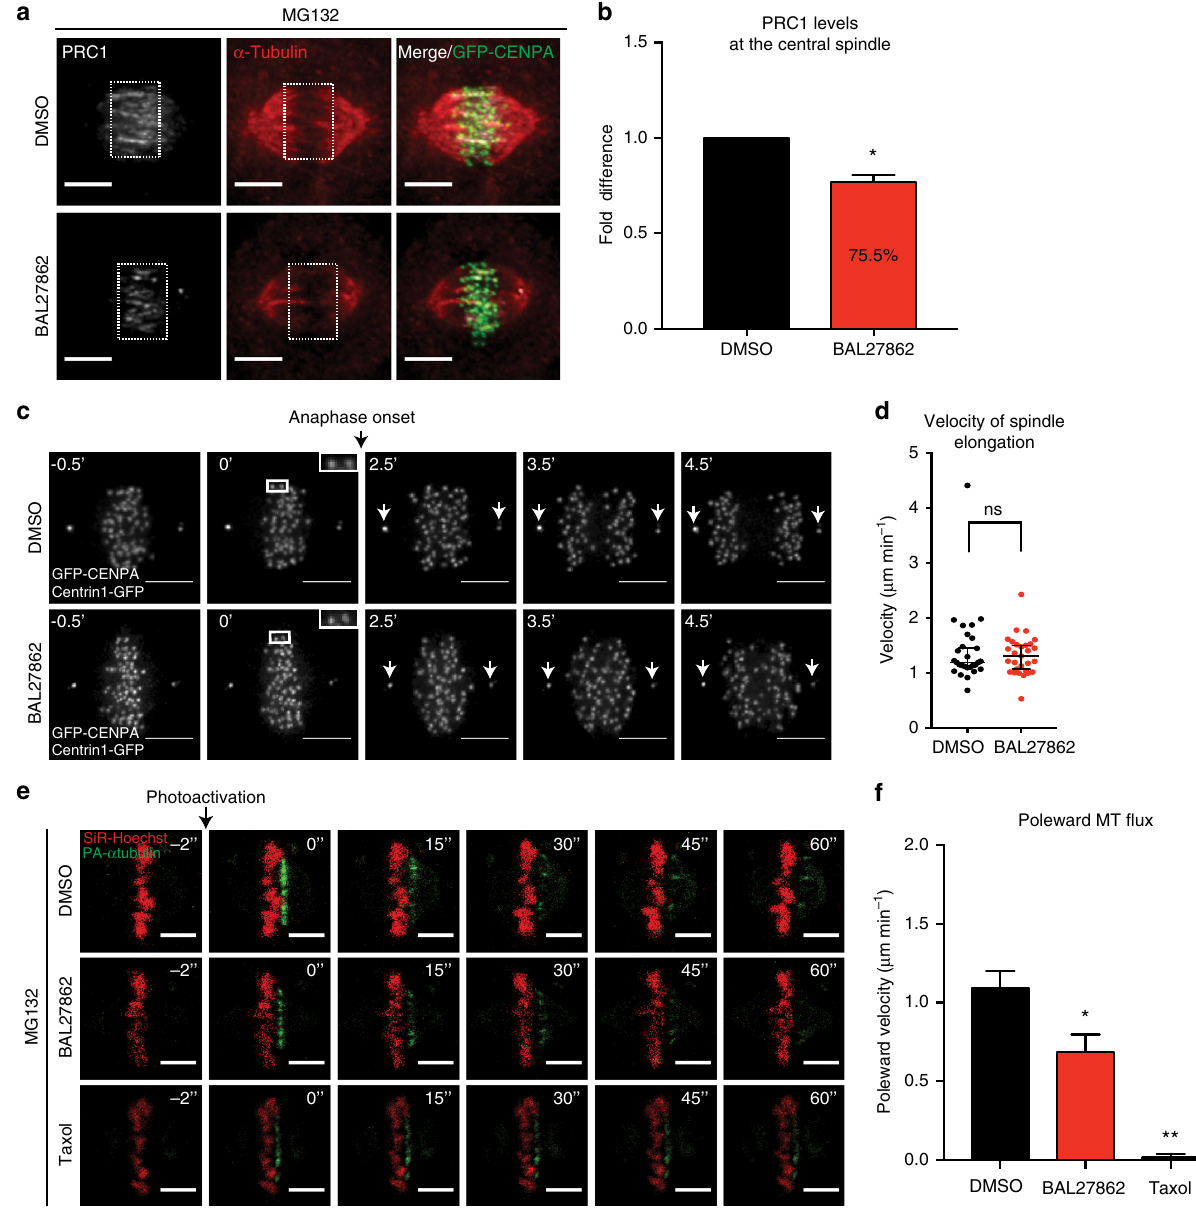
Fig. 8 Low doses of BAL27862 speci fi cally affect anaphase A. a Immuno fl uorescence images of hTert-RPE1 GFP-CENPA cells treated in parallel with DMSO or 12 nM BAL27862, and 10 μ M MG132 after staining for α -tubulin (red) and PRC1 (grey). Scale bars = 5 μ m. b Quanti fi cation of PRC1 intensities in hTert- RPE1 GFP-CENPA cells normalized to DMSO; N = 3, n = 104 – 105 cells, error bars are s.e.m, * represents p = 0.026, ratio paired two-tailed t -test. c Time lapse images of hTert-RPE1 Centrin1-GFP/GFP-CENPA cells treated with DMSO or 12 nM of BAL27862 (4 h). Scale bars = 5 μ m. White arrows at spindle poles indicate position of centrosomes (Centrin1-GFP). d Quanti fi cation of spindle elongation velocities of hTert-RPE1 Centrin1-GFP/GFP-CENPA cells treated with DMSO or 12 nM BAL27862; N = 4, n = 28 – 29 cells, error bars are 95% CI of medians, p = 0.968, two-tailed Mann – Whitney test. e Time lapse images of hTert-RPE1 PA-GFP- α -tubulin cells treated in parallel with 25 nM SiR-Hoechst (red); DMSO, 12 nM BAL27862, or 10 μ M taxol; and 10 μ M MG132. The green signal indicates the position of the PA-GFP- α -tubulin over time. Scale bars = 5 μ m. f Quanti fi cation of poleward MT fl ux rates of hTert- RPE1 PA-GFP- α -tubulin cells; N = 3, n = 30 – 49 k - fi bres from 17 to 30 cells, error bars are s.e.m., * represents p = 0.041 DMSO vs. BAL27862; ** represent p = 0.004 for BAL27862 vs. taxol, in two-tailed ANOVA